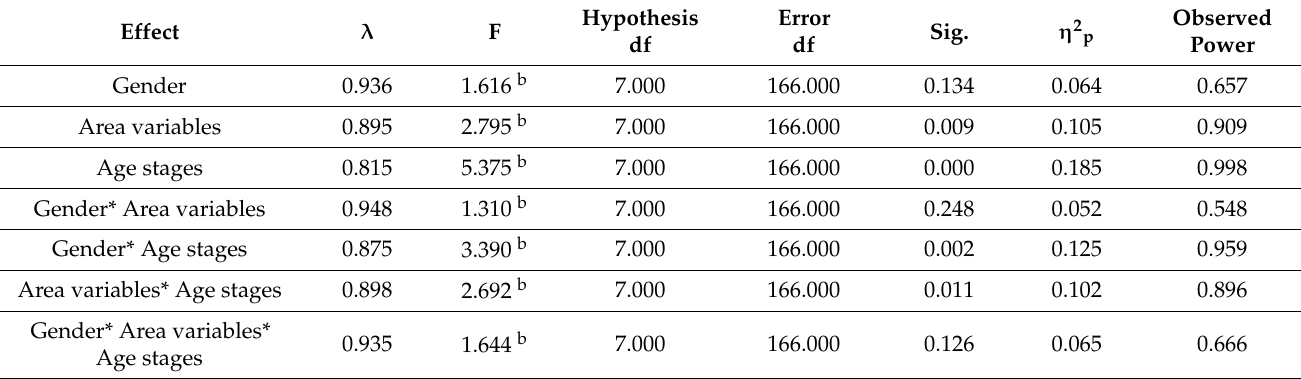
Table 2. The results of the Multivariate Testsa (MANOVA)/F1(leisure